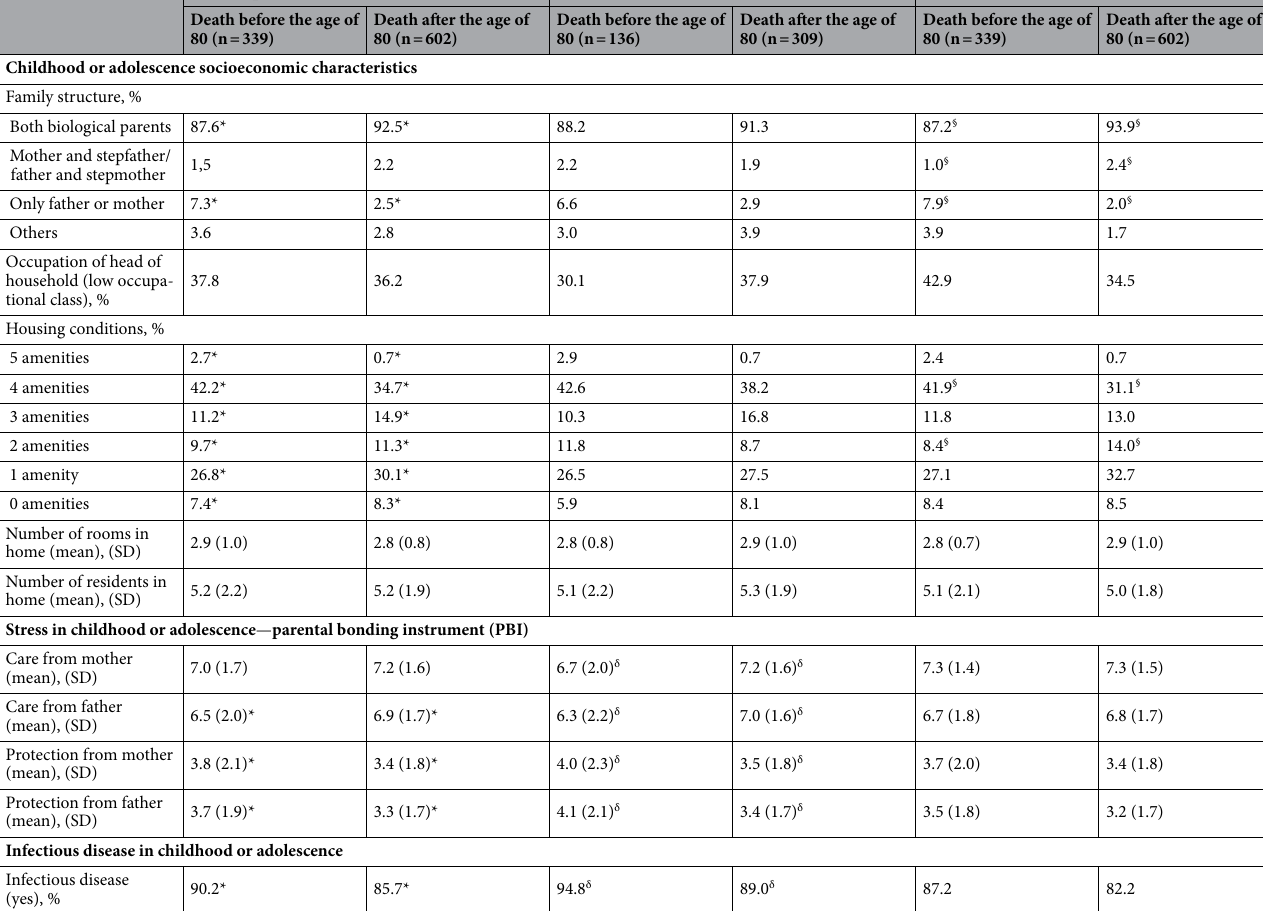
Table 3. Characteristics of adverse events in childhood or adolescence who died before and after the age of 80 during 12-month follow-up. *Differences between full sample in category ’death before the age of 80’ versus full sample in category ’death after the age of 80’. δ Difference between women in category ’death before the age of 80’ versus women in category ’death after the age of 80’; § Difference between men in category ’death before the age of 80’ versus men in category ’death after the age of